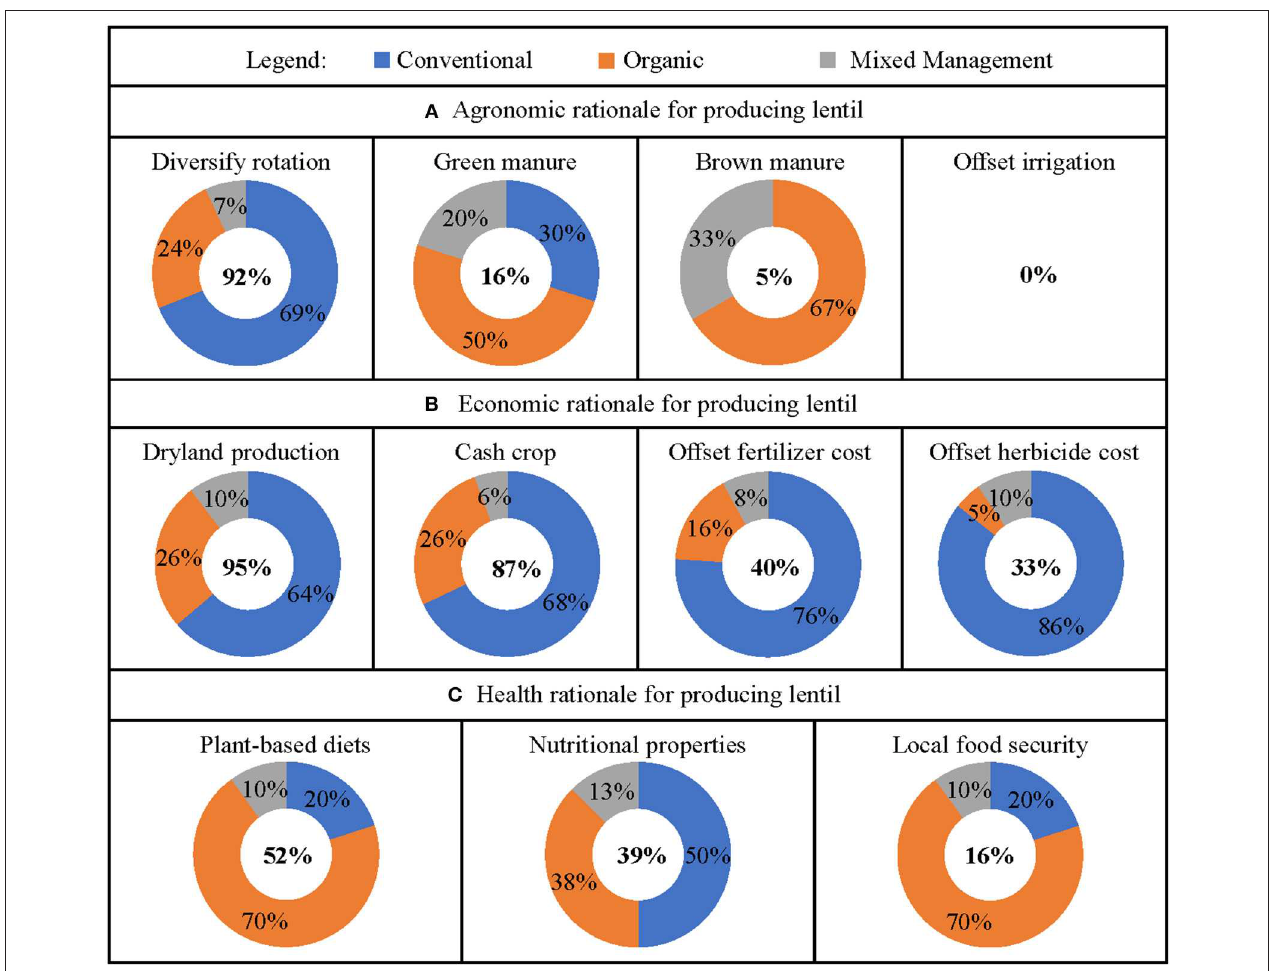
FIGURE 4 | Agronomic, economic, and health rationale. (A) Total percentage (center) and the proportion of conventional, organic, and mixed management producers that reported agronomic reasons ( n = 63) for growing lentil that include to diversify crop rotation, green manure ( p = 0.0274), brown manure ( p = 0.0407), and to offset irrigation. (B) Total percentage (center) and the proportion of conventional, organic, and mixed management producers that reported economic for growing lentil that include to capitalize on dryland production, cash crop ( p = 0.0178), offset fertilizer cost, offset herbicide costs ( p = 0.0385). (C) Total percentage (center) and the proportion of conventional, organic, and mixed management producers that reported health reasons ( n = 61) for growing lentil that include to support plant-based diets, nutritional properties, and to support local food security ( p =